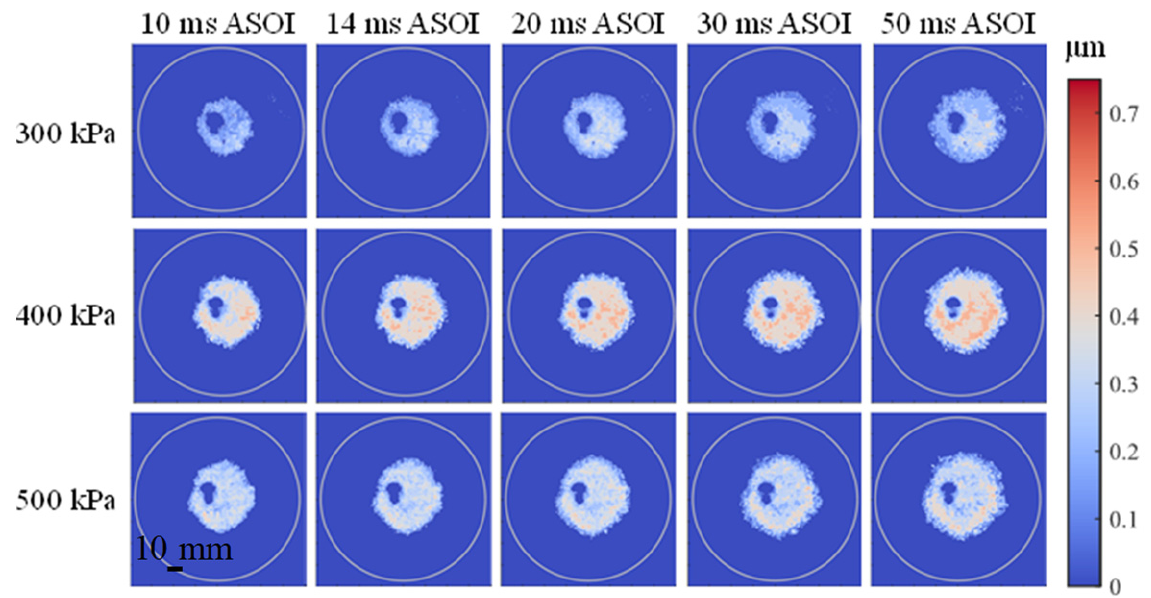
Figure 17. Pseudo color images of fuel film on the wall with temperature 293 K under different P inj (300 kPa to 500 kPa).